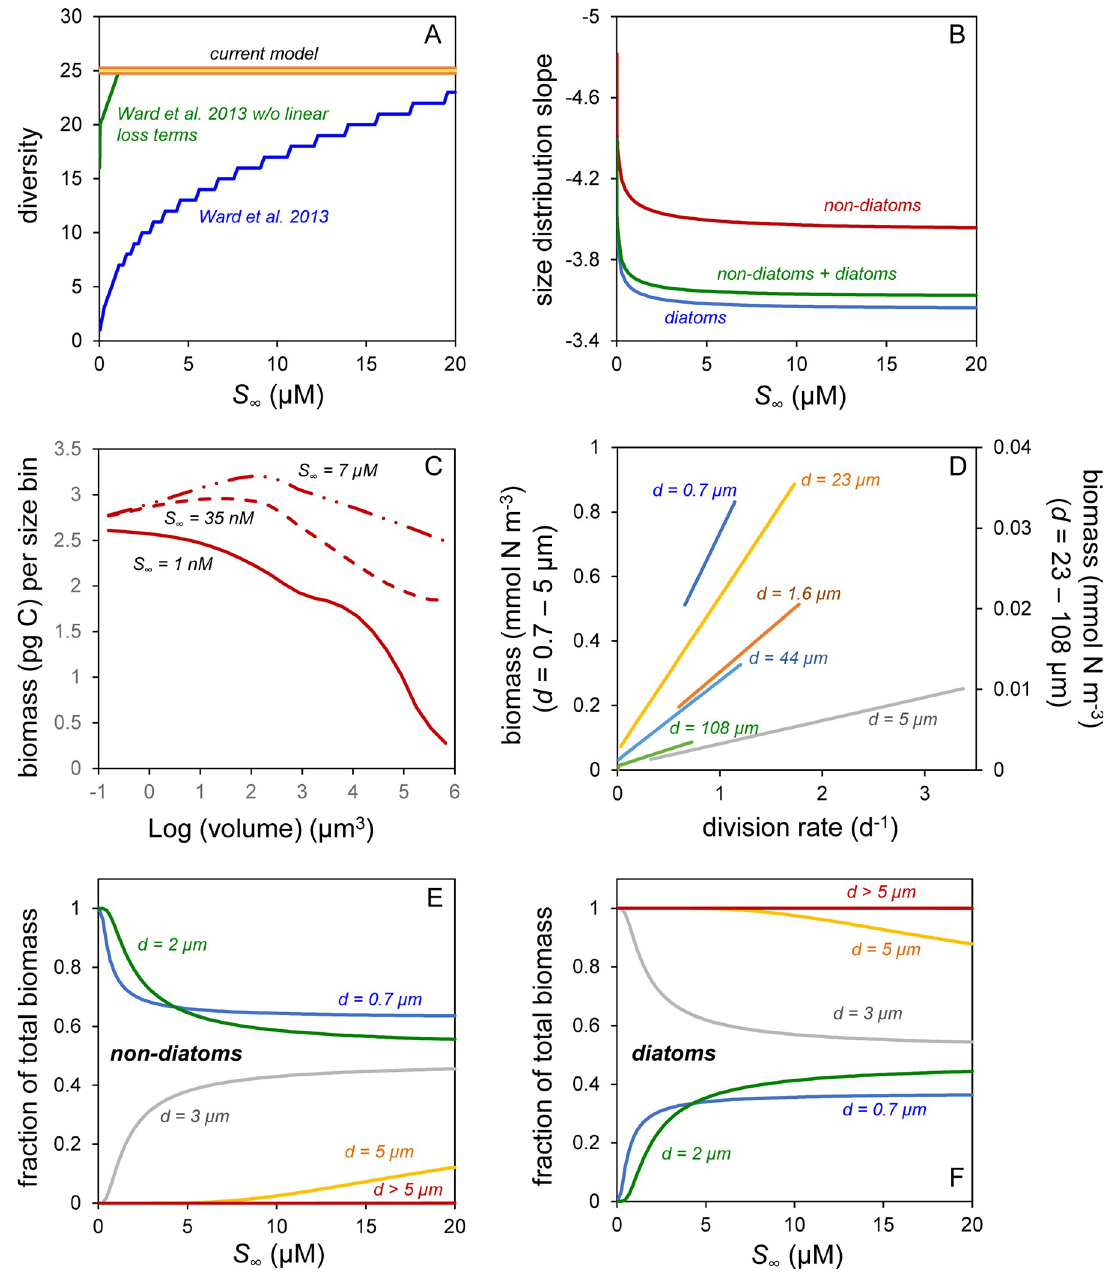
Fig 5. Properties of model-based steady state phytoplankton communities. (A) Phytoplankton diversity as a function of far-field nutrient concentration ( S 1 ) for model runs initiated with 25 distinct ‘species’ (size classes). Heavy red line, thin yellow line = Non- diatom and diatom diversity for ecosystem model developed herein, respectively. Blue line = Phytoplankton diversity predicted by the Ward et al. [10] model. Green line = Diversity predicted by Ward et al. [10] model but with non-grazing loss terms ( m , κ ) omitted. (B) Phytoplankton size distribution slopes (SDS) for the linear relationship between the logarithm of cell number concentration per unit length and logarithm of cell diameter as a function of S 1 . Colors = Model runs for non-diatom, diatom, and mixed communities. (C) Examples of the shift in dominance from small cells to large cells as the SDS increases with increasing S 1 (labeled next to line). Data are for non-diatom cell types where abundance and cell volume data values are converted to biomass following Menden-Deuer & Lessard [20]. (D) Relationships between phytoplankton division rates and biomass for cell diameters ranging from 0.7 to 108 μ m. Left axis = Results for cell diameters ranging from 0.7 to 5 μ m. Right axis = Results for cell diameters ranging from 23 to 108 μ m. (E) Fraction of total phytoplankton biomass from the multispecies model runs that is attributable to different size classes of non-diatoms and as a function of S 1 . Modeled size classes ranged from 0.7 to 135 μ m, but non-diatoms only contributed significantly to total biomass at cell diameters below ~5 μ m. (F) Same as in (E) except showing results for diatoms.